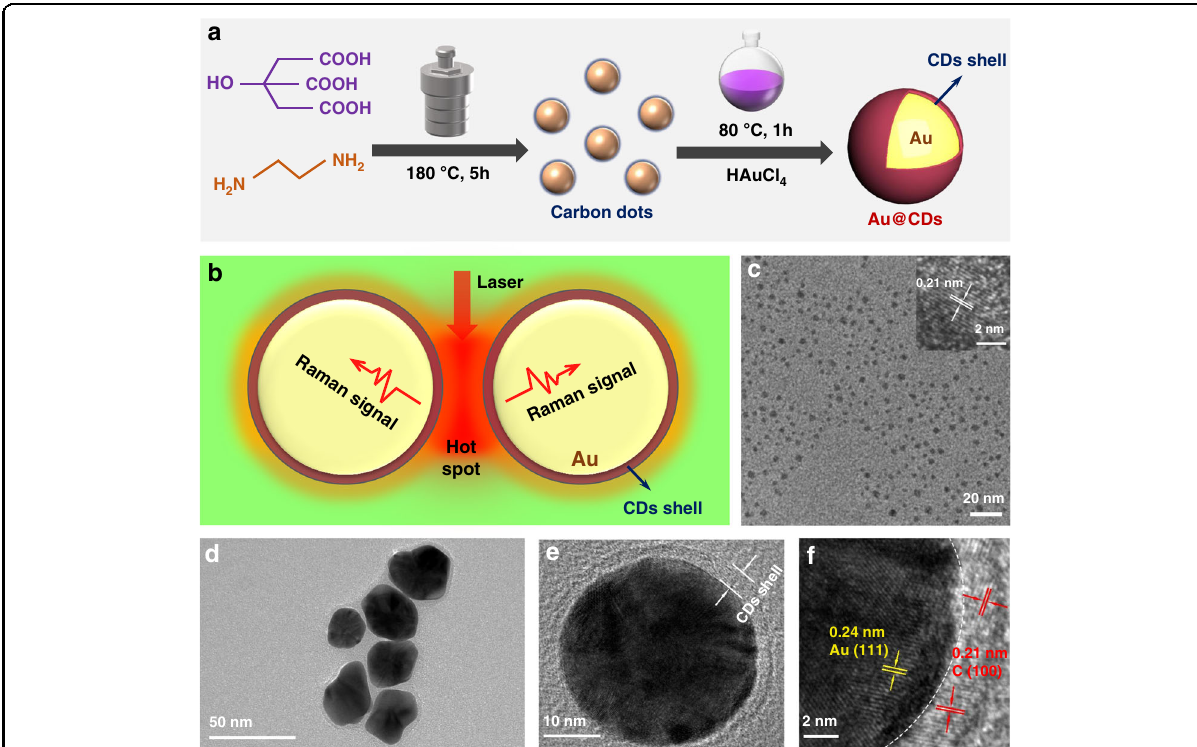
Fig. 1 Morphology of CDs and Au@CDs. a The synthesis procedure of the core-shelled Au@CDs nanospheres. b Raman enhancement mechanism of core-shelled nanocomposites. c HRTEM image of initial CDs, d , e TEM image of as-prepared Au@CDs nanospheres, and f HRTEM image of the interface region of